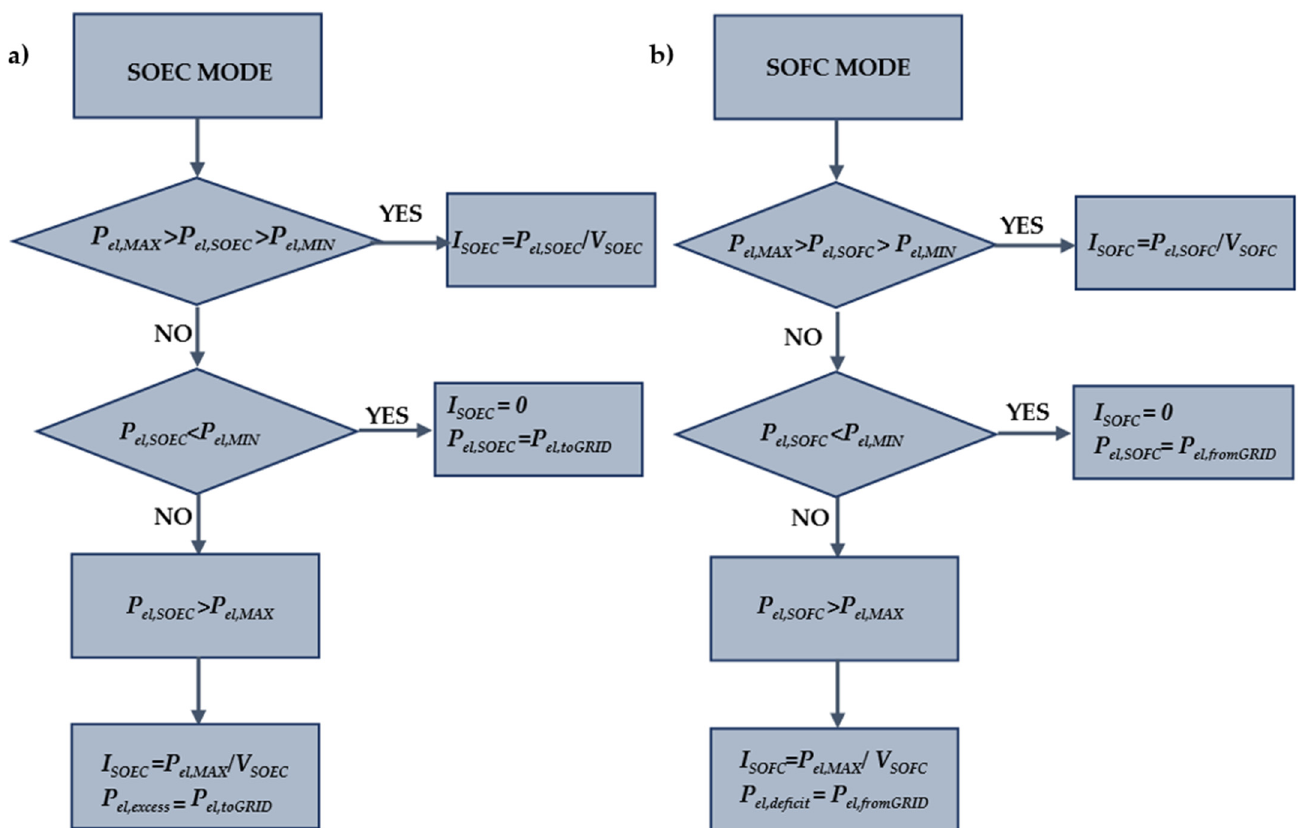
Figure 4. Flow chart of the feedback control for the electrolyzer ( a ) and the fuel cell ( b ). Further design parameters of the model proposed are reported in Table 2.